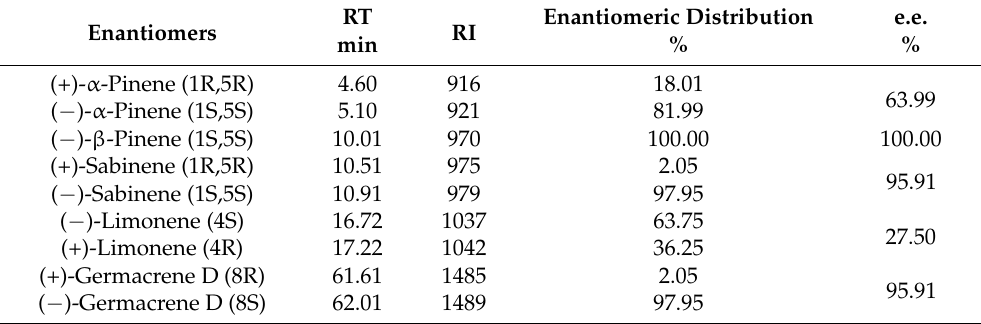
Table 3. Enantiomeric distribution of chiral constituents occurring in the EO of A. cherimola .